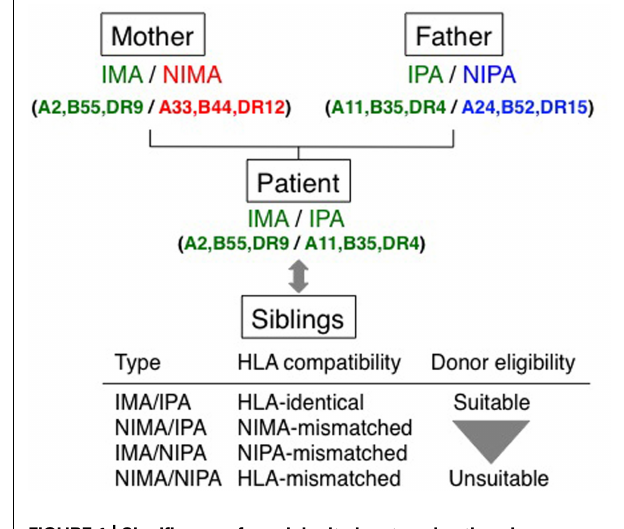
FIGURE 1 | Significance of non-inherited maternal antigen in transplantation. The nomenclature of the HLA haplotype is patient-oriented in the transplantation field. Children inherit one haplotype from each of parent. Siblings of the patient share one haplotype with the donor, and the other haplotype is the non-inherited haplotype.The HLA haplotypes in parentheses are shown as representative examples.When the patient is transplanted with donor from one of the parents or from a haploidentical sibling, the non-inherited maternal HLA antigens (NIMA) or non-inherited paternal HLA antigens (NIPA) are the mismatched haplotype. The NIMA and NIPA-mismatched siblings can be potential